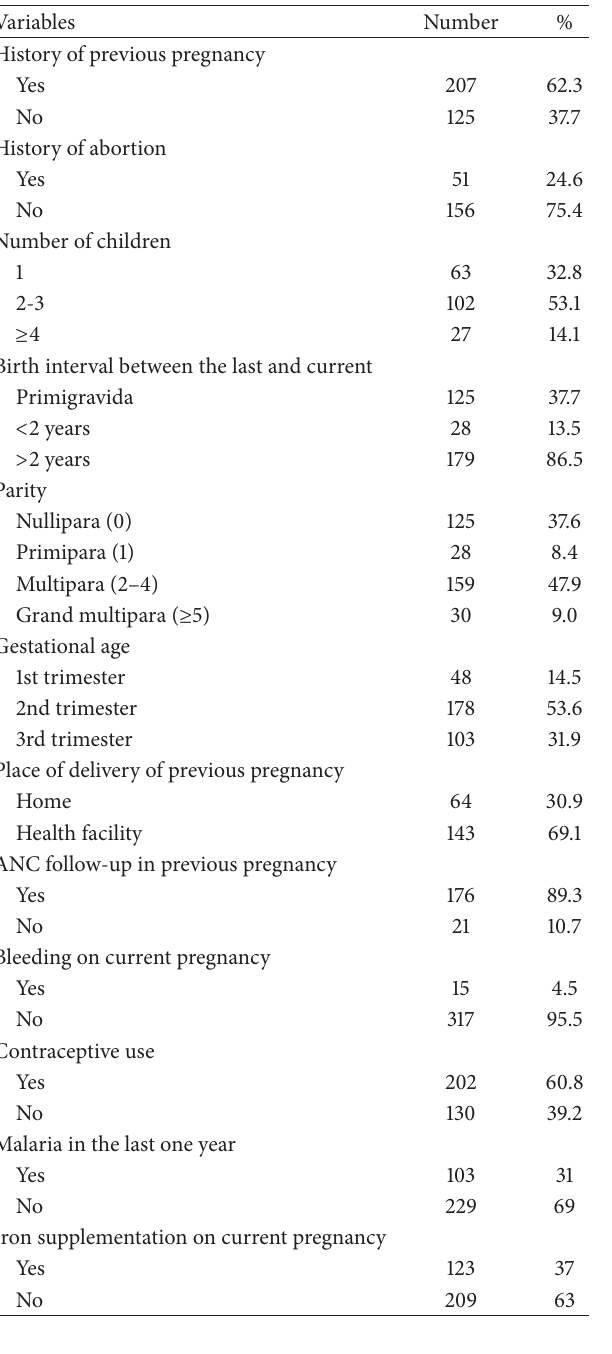
Table 2: Obstetrics related characteristics among ANC attendees in health institutions of Arba Minch town, February to April 2015 ( 𝑛 = 332 ).